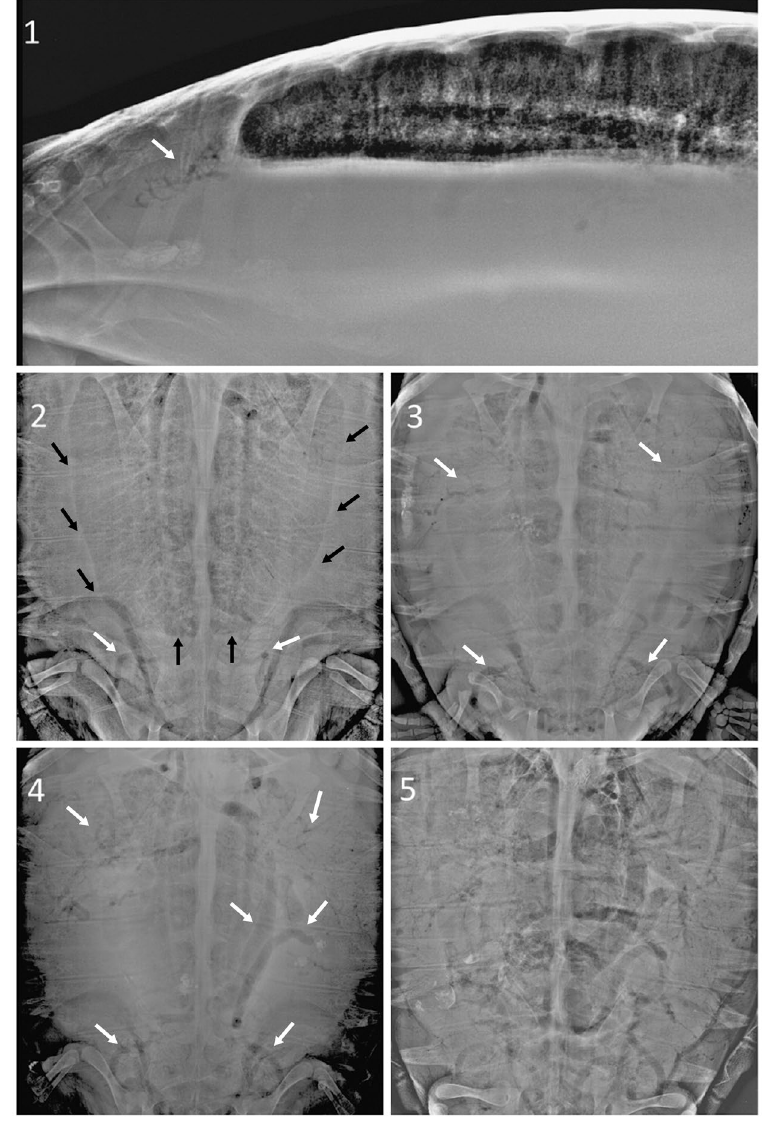
Figure 1. Examples of different degrees of gas embolism (GE) demonstrating the scoring criteria used in this study. Gas emboli are detected as radiolucent (black) anomalies following blood vessels (white arrowheads). Lung shape and contrast are also reduced (pulmonary silhouette indicated by black arrowheads) in dorsal- ventral (DV) radiographs as pulmonary parenchyma becomes collapsed by gas accumulation and expansion of other coelomic organs. Score (1) very mild GE within the kidneys in a lateral-lateral radiograph. Score (2) mild GE is clearly visible within the kidneys in a dorsal-ventral (DV) radiograph. Score (3) moderate GE is evident within both the kidneys and some peripheral hepatic vessels. Note that the reduced pulmonary silhouette compared to (2). Score (4) moderate-severe GE is observed within some larger blood vessels, including hepatic vessels and precavas, as well as the kidneys. The lung silhouette is further reduced. Score (5) abundant gas is present within the heart and principal veins (precavas, postcava, hepatic veins and portal-renal system), as well as many other peripheral areas and internal organs (including liver and kidney).